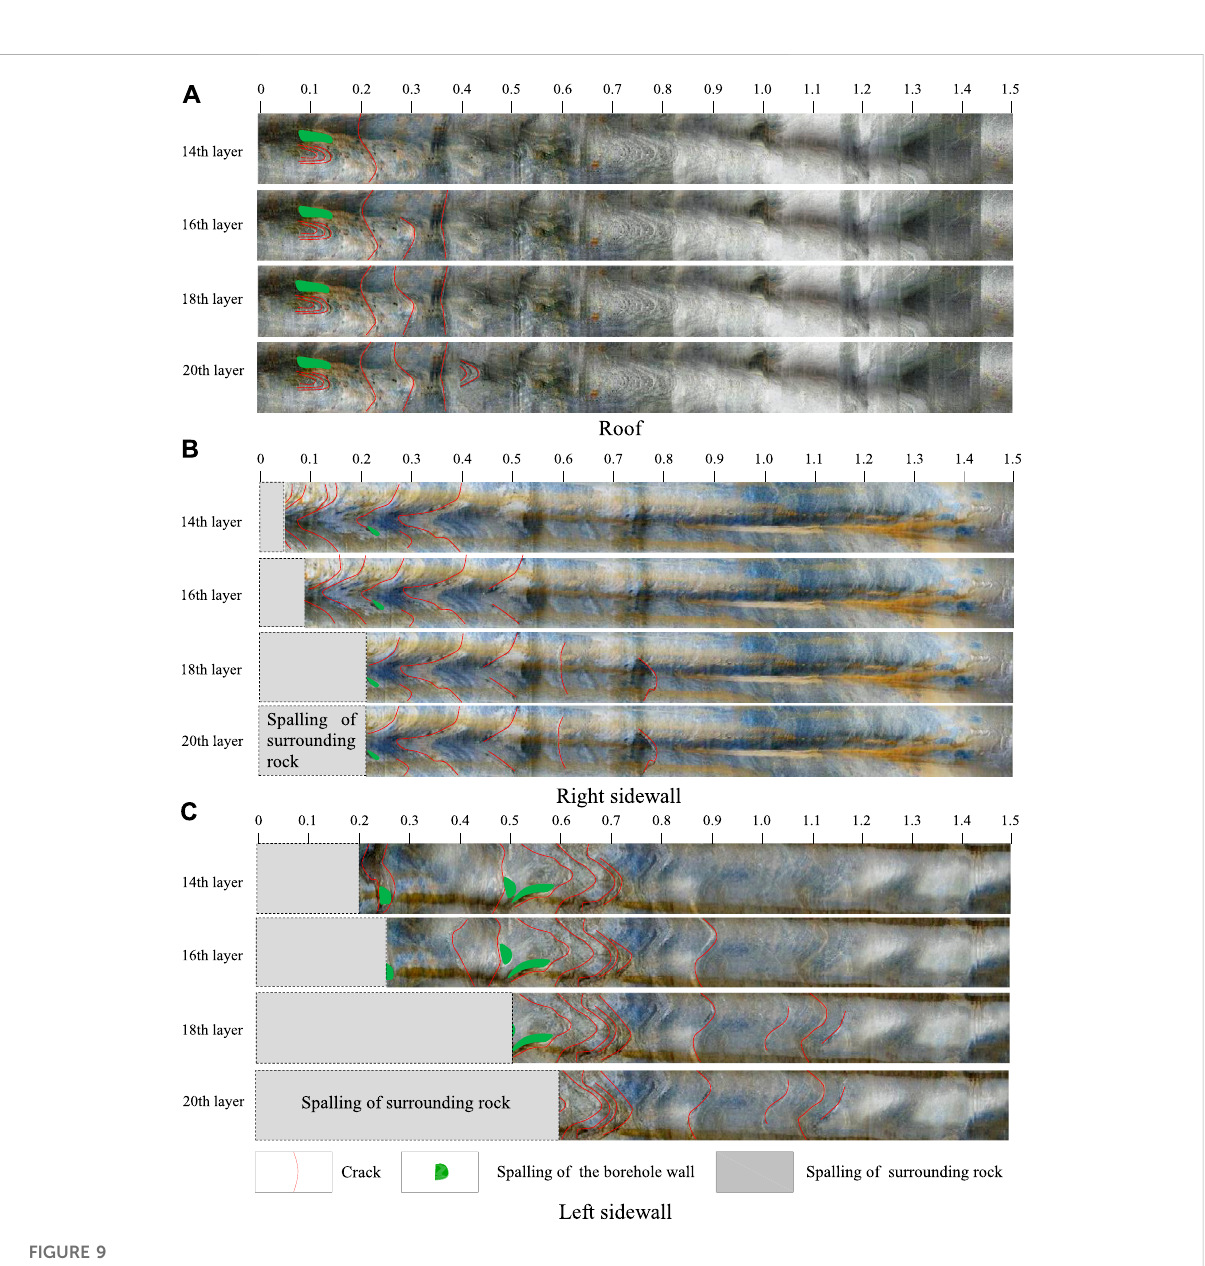
FIGURE 9 Failure of surrounding rock in the 13# stope ramp at different mining